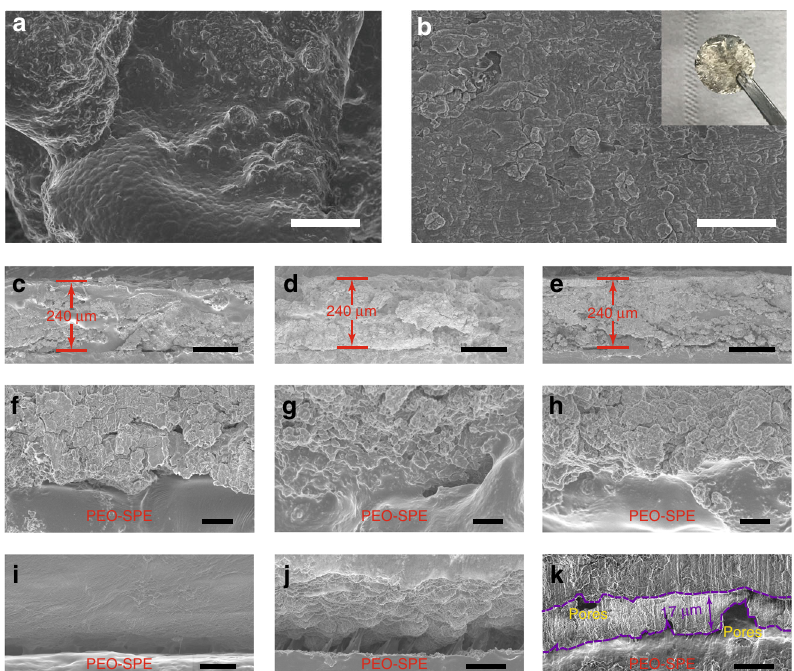
Fig. 4 Morphological and structural characterizations of PEO-DLSL and PEO-Li-foil electrode at different states. a SEM image showing the DF-Si-Li 0.8 microparticles after a thin layer of PEO-SPE coating (scale bar = 50 μ m). b SEM image demonstrating the fl at surface morphology of the PEO-DLSL electrode (scale bar = 20 μ m). The inset is the photograph of the as-fabricated composite anode. c – e Cross-sectional SEM images of pristine PEO-DLSL electrode ( c ), after 4 mAh cm − 2 of Li stripping ( d ), and 4 mAh cm − 2 of plating Li back ( e ). The current density was set at 0.5 mA cm − 2 for all of the above characterizations (scale bar = 200 μ m). f – h The corresponding magni fi ed SEM images of the electrode from c to e , showing the morphologies at the interface of the PEO-DLSL electrode and PEO-SPE (scale bar = 5 μ m). i – k , Cross-sectional SEM images showing the morphologies at the interfaces of Li foil and PEO-SPE (scale bar = 20 μ m). The intimal surface of Li foil is smooth ( i ). After 4 mAh cm − 2 of Li stripping out, a rough Li-foil surface could be observed ( j ). When 4 mAh cm − 2 of Li was plated back, a layer of deposited Li (~17 μ m) appeared at the interface with pores and cracks ( k